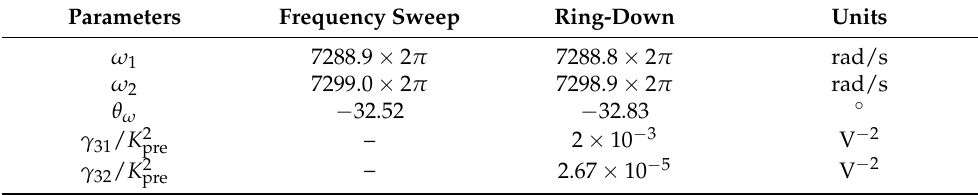
Table 3. The measured modal parameters by the frequency sweep and the ring-down